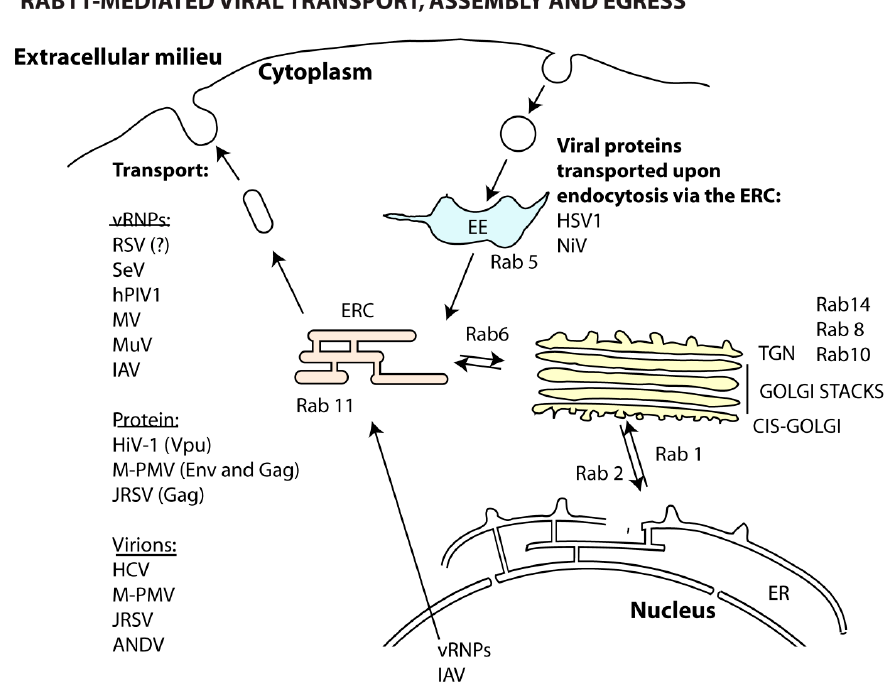
Figure 6. Involvement of the ERC in viral assembly, budding and release. The ERC can be used by different viruses for transport of viral genome particles and proteins towards assembly sites. Moreover, it is also involved in the transport of entire virions to the cell surface.